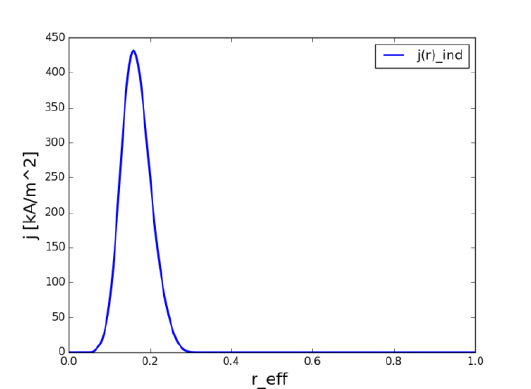
Figure 9: ECCD profile, simulated with TRAVIS, as a function of the normalised